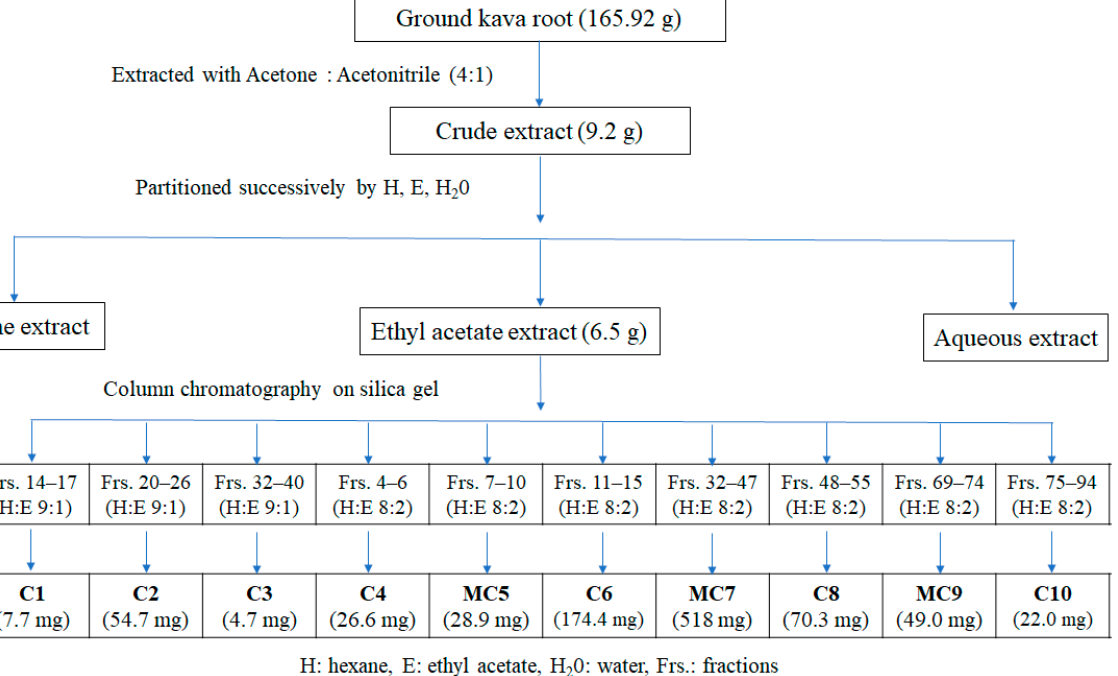
Figure 1. Fractionation and column chromatography separation of kava root.